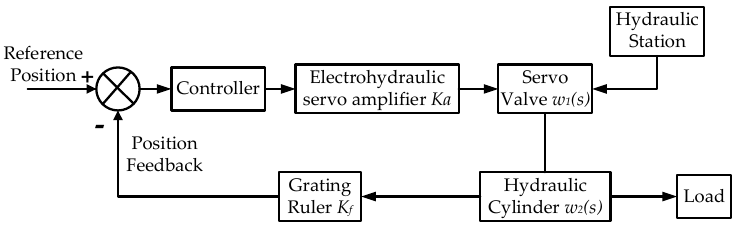
Figure 3. Block diagram of the CPP control system.